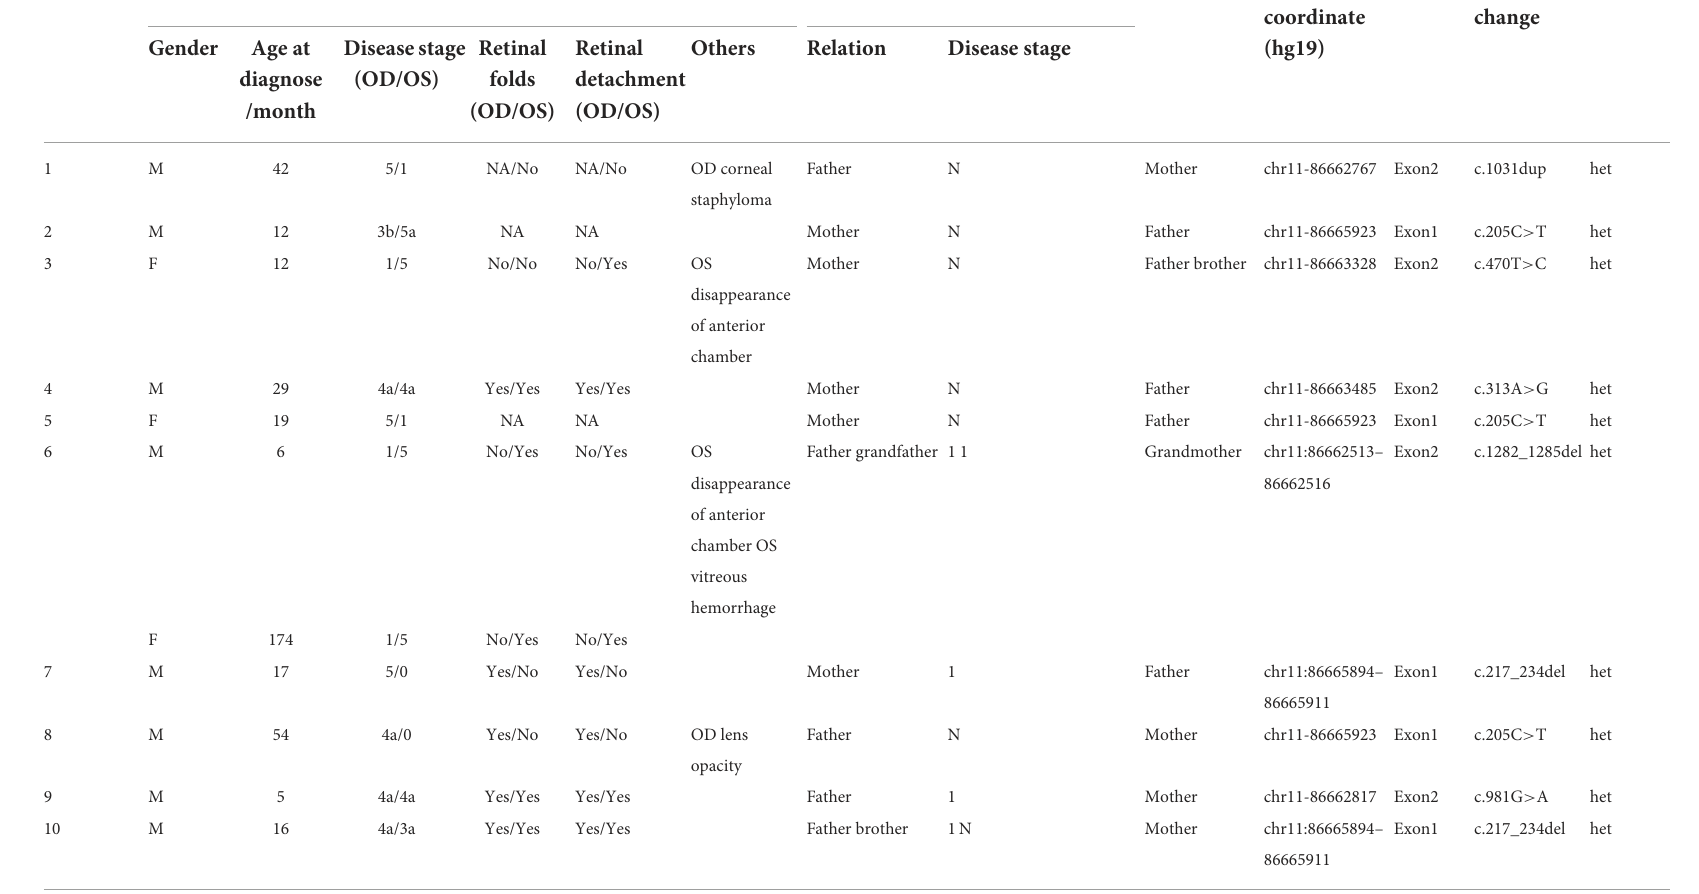
TABLE 1 Clinical details and genetic test results of 34 subjects from 10 FEVR families. Family